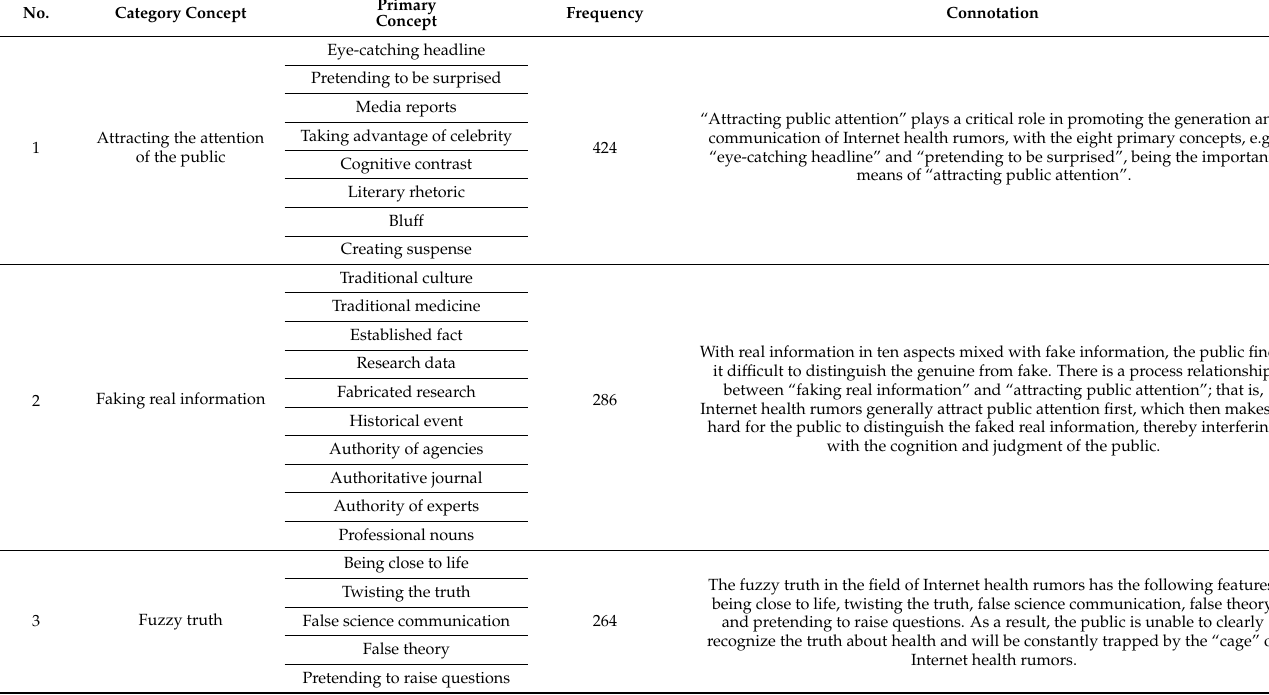
Table 2. Primary Concept and Category